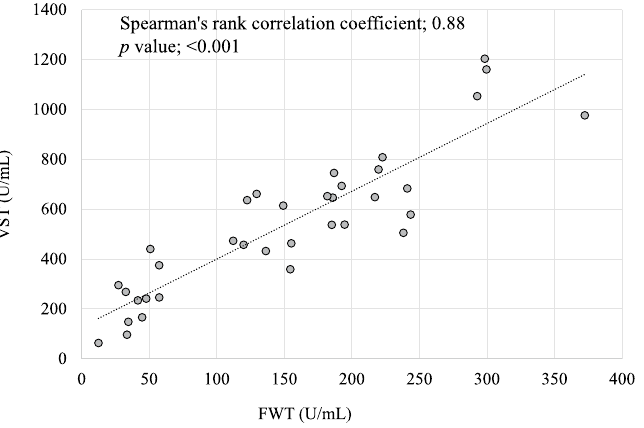
Figure 1. Correlation between fingertip whole blood sampling test (FWT) and venous serum test (VST). Samples for FWT and VST were obtained from 35 healthcare workers at the Okayama University